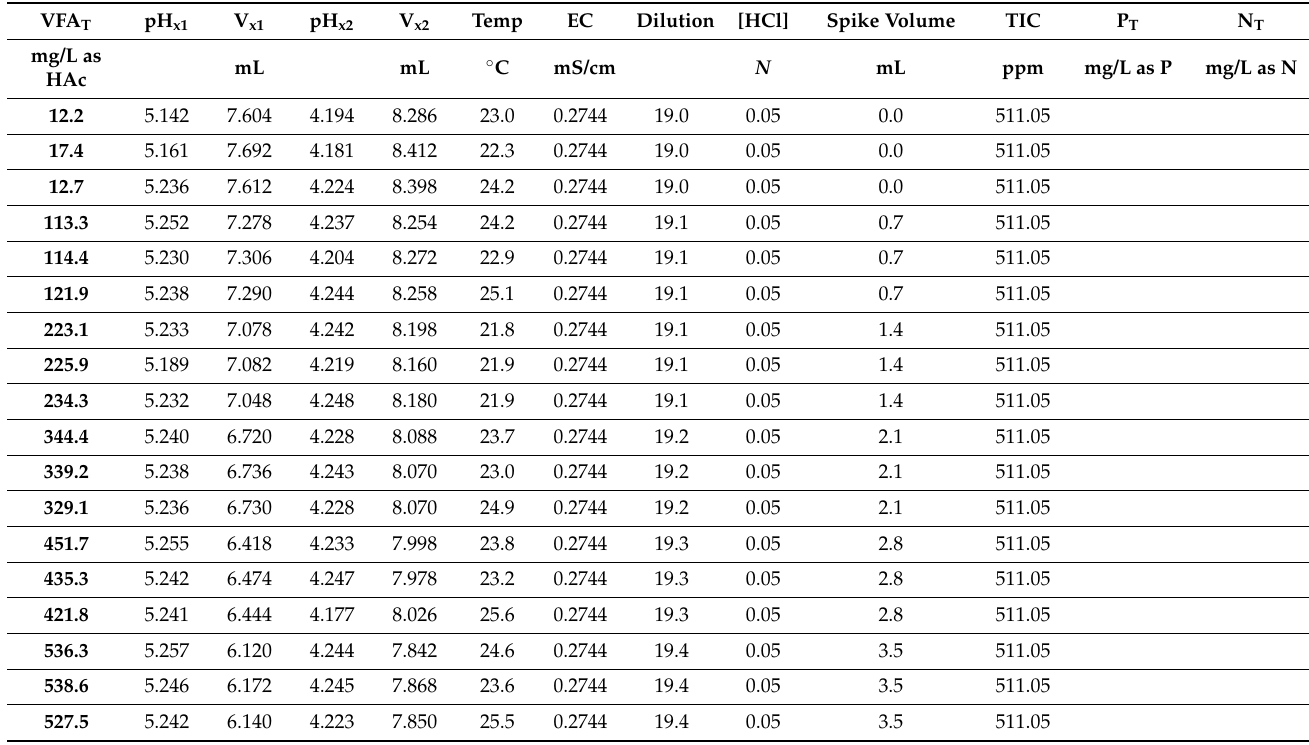
Table A3. Results of Zichron VFA T + spiking.